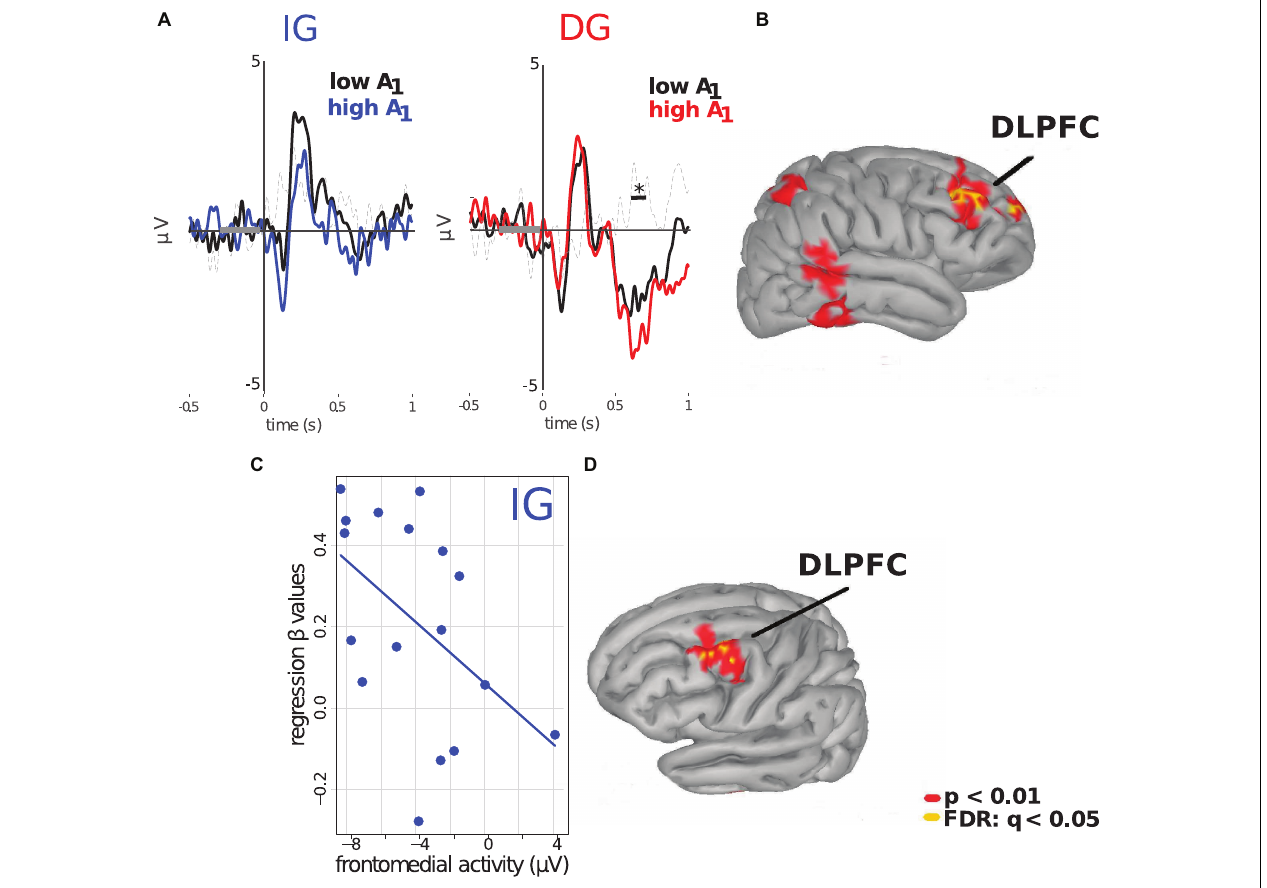
FIGURE 4 | Frontomedial negativity encodes the magnitude of A 1 under the DG condition. (A) Left: ERPs of subjects when they received an allocation in the IG. Blue and black lines represent subjects’ ERP when values of A 1 were above and below €6, respectively. Right: ERPs of subjects for the DG condition. Red and black lines represent subjects’ ERP when values of A 1 were above and below €6, respectively. Significant differences were obtained in a time windows between 550 and 650 ms after stimulus onset, specifically for this condition. (B) Cortical source projections (FDR: q < 0.05; p < 0.01, uncorrected). *indicates p < 0.05. Subjects’ average FMN predicts their responses to trust: (C) Regression of average ERPs in the frontomedial cluster ( X -axis) versus the β -values obtained from Equation 1 ( Y -axis) for the IG (intentions-based) condition ( γ 1 = -0.037; p = 0.045). (D) Cortical source projections (FDR: q < 0.01; p < 0.005, uncorrected).